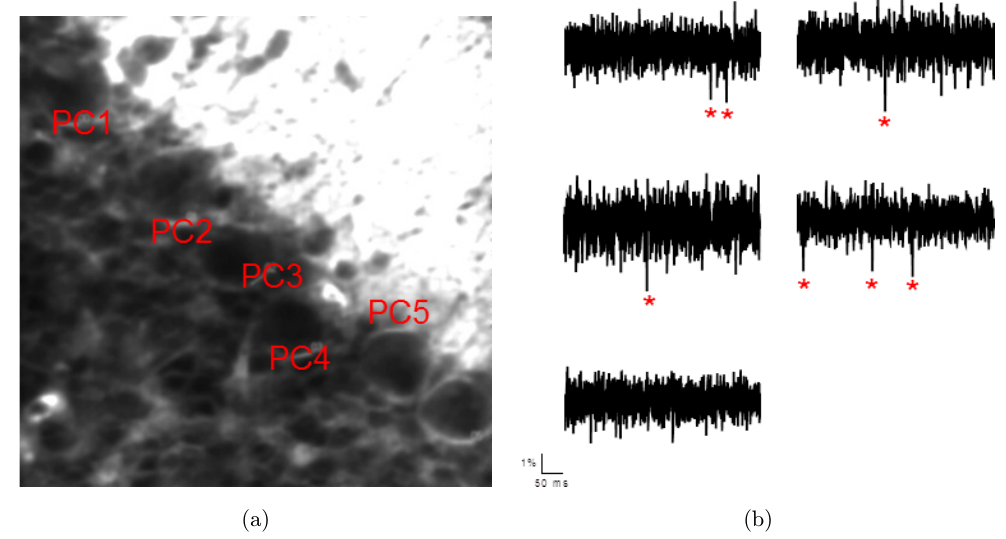
Fig. 9. Optical multi-unit recording of spontaneous electrical activity. (a) TPF image of a cerebellar slice taken at a depth of 90 (cid:1) m. The multi-unit TPF recording was carried out on 5 PCs, with membrane integration time per neuron (cid:4) 90 (cid:1) s. (b) Multi- plexed recording of spontaneous electrical activity from the 5 PCs. The relative °uorescence variation ( (cid:1) F = F ) is shown as a function of time. Single action potentials are clearly visible and are indicated by red stars.